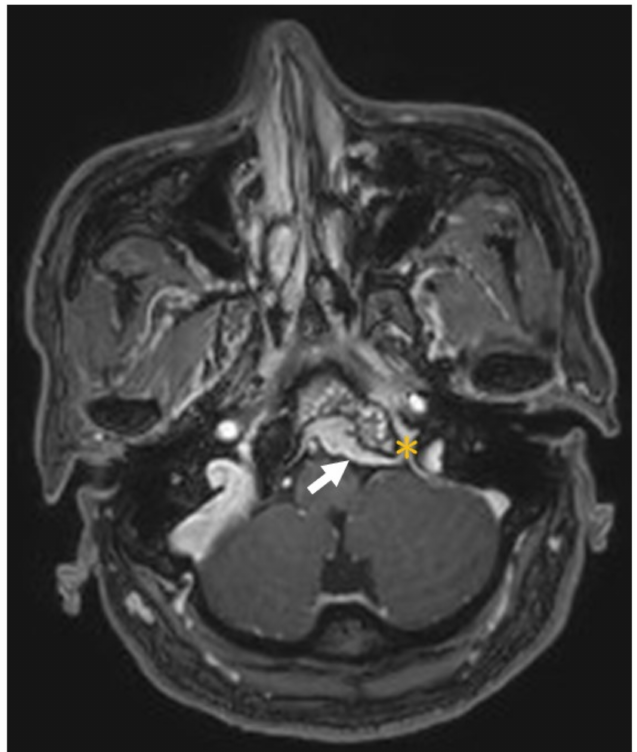
Figure 1. Magnetic resonance imaging of an enhanced lesion in the retropharyngeal space with encasement of the clivus bone, internal carotid artery, jugular foramen (asterisk) and hypoglossal canal (not shown). The lesion was located outside the dura mater (arrow).